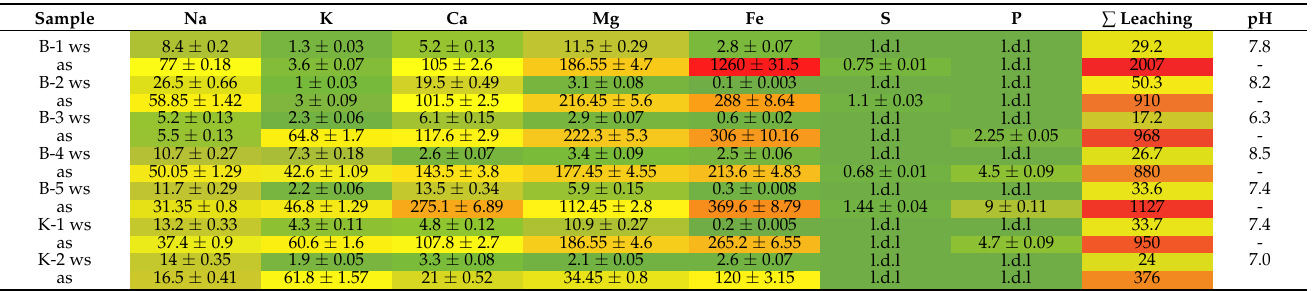
Table 4. Heatmap of water soluble (ws) and acid soluble (as) elements fractions in 10 g of clay samples,